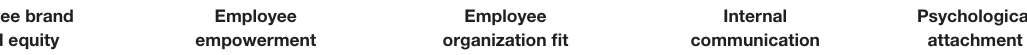
TABLE 2 | Outer loadings (convergent validity).